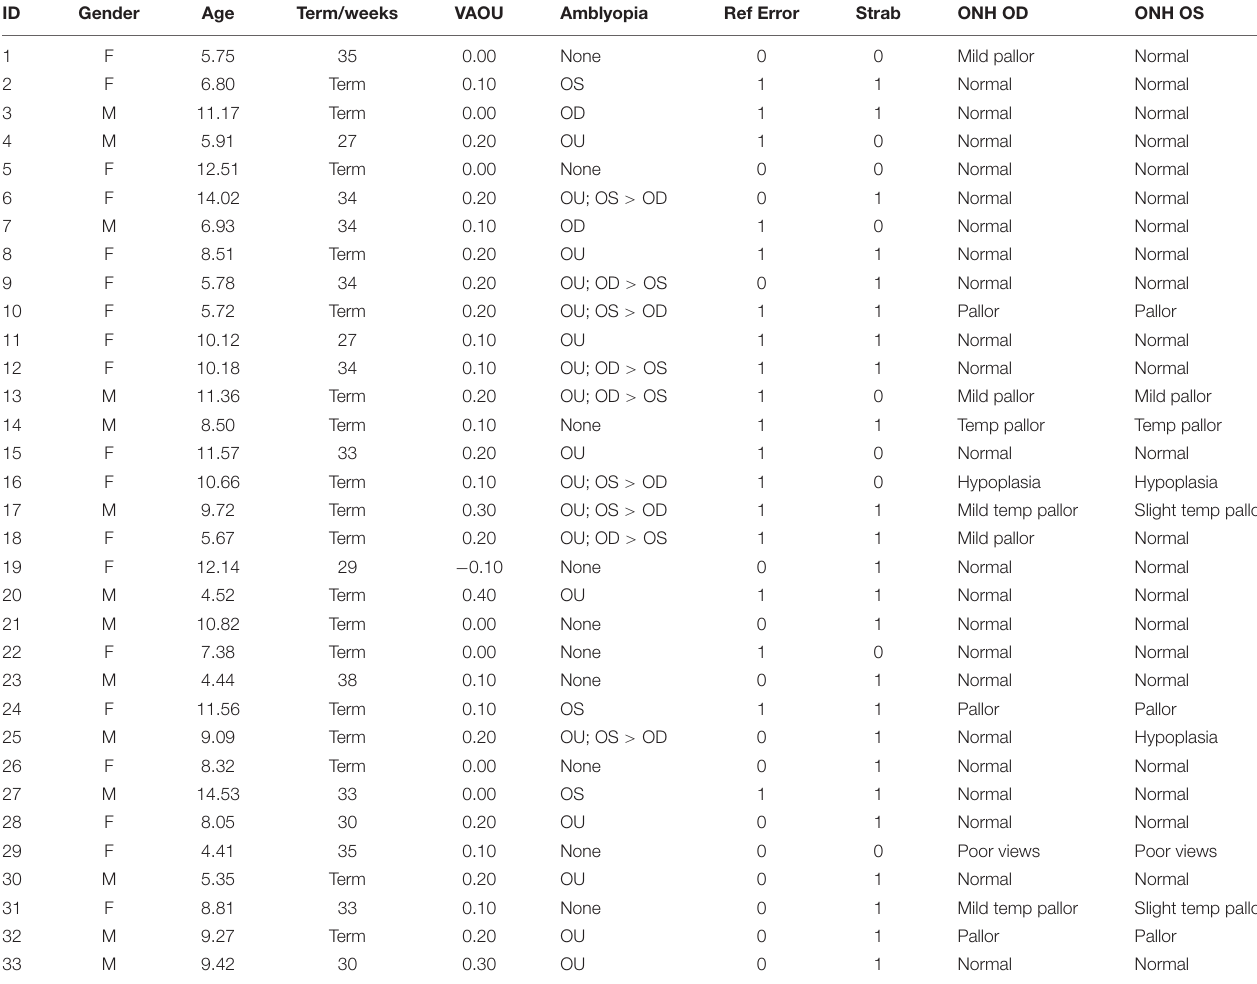
TABLE 1 | Clinical characteristics of children with